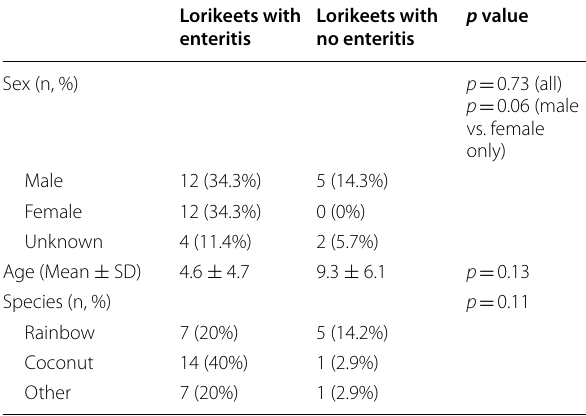
Table 3 Lorikeet Demographics for CZA lorikeets submitted to pathology. The Freeman‑Halton extension of the Fisher’s Exact test was used to calculate p values for sex and species. A Kruskal– Wallis test was used to calculate the p value for